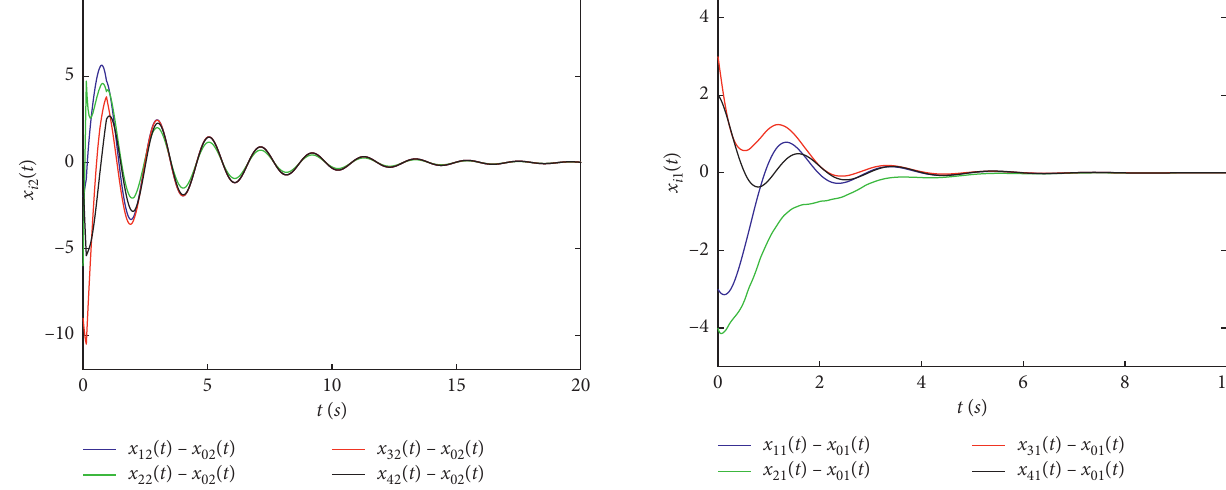
Figure 6: The 1st state error trajectory of each agent under protocol (35).